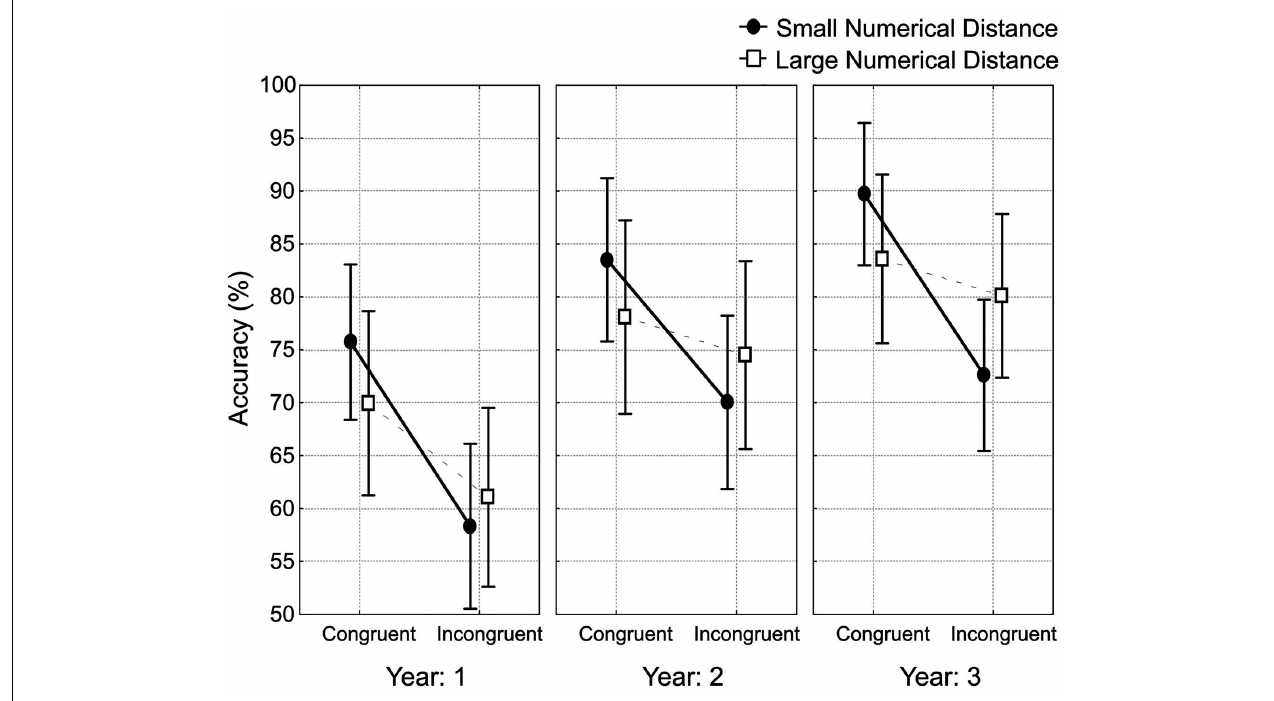
FIGURE 1 | Developmental trends, by year group, of Congruency × Numerical Distance, for accuracy. The error bars indicate 95% confidence intervals.